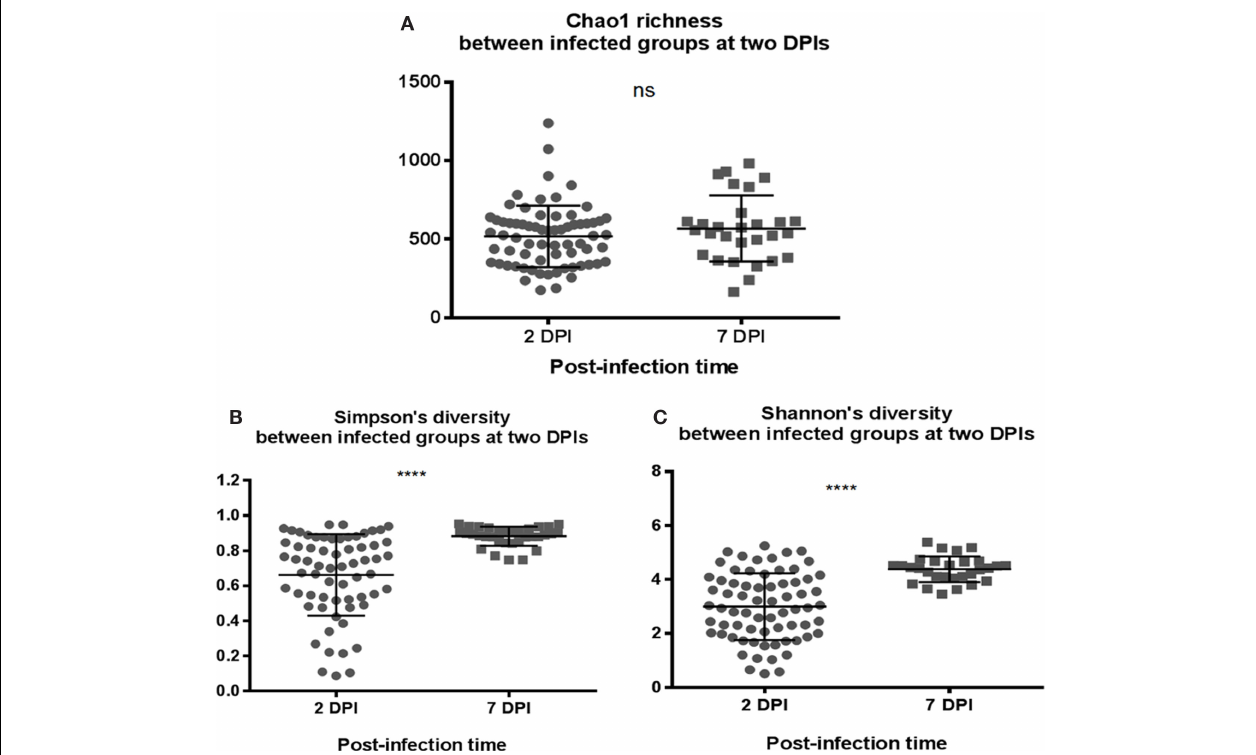
FIGURE 4 | Comparison of the diversity indices of S . Enteritidis-infected chicks at different time-points of post infection periods at 2 and 7DPI . (A) Chao1 richness estimate, (B) Simpson’s diversity, and (C) Shannon’s diversity index were analyzed. (B,C) Simpson and Shannon’s diversity showed significant difference in microbial diversity between two infected groups of chicks with increased diversity in microbiota composition at 7DPI compared to 2DPI. Both diversity metrics were evaluated using Mann–Whitney U test. **** p value < 0.0001.